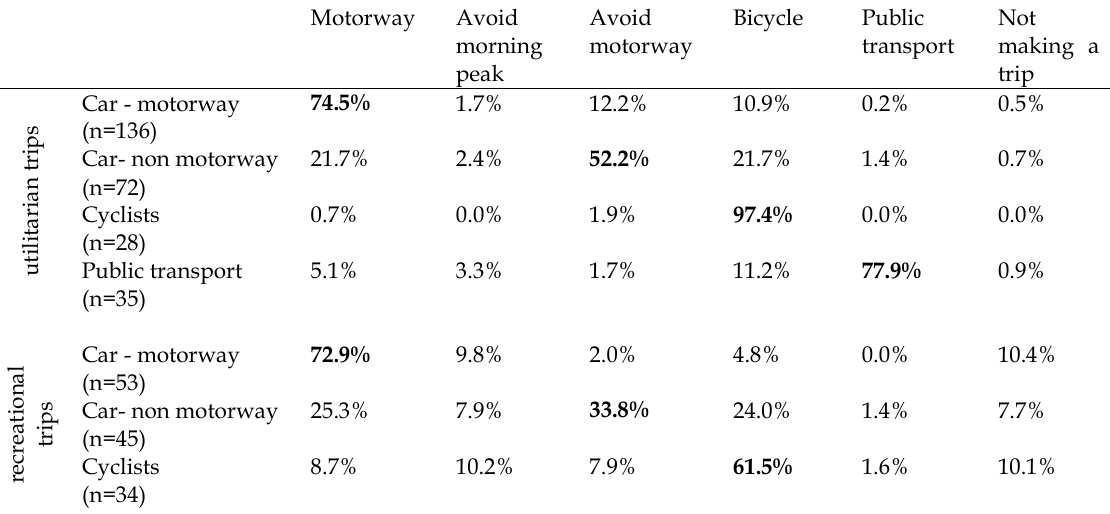
Table 4. Choice probabilities base scenario